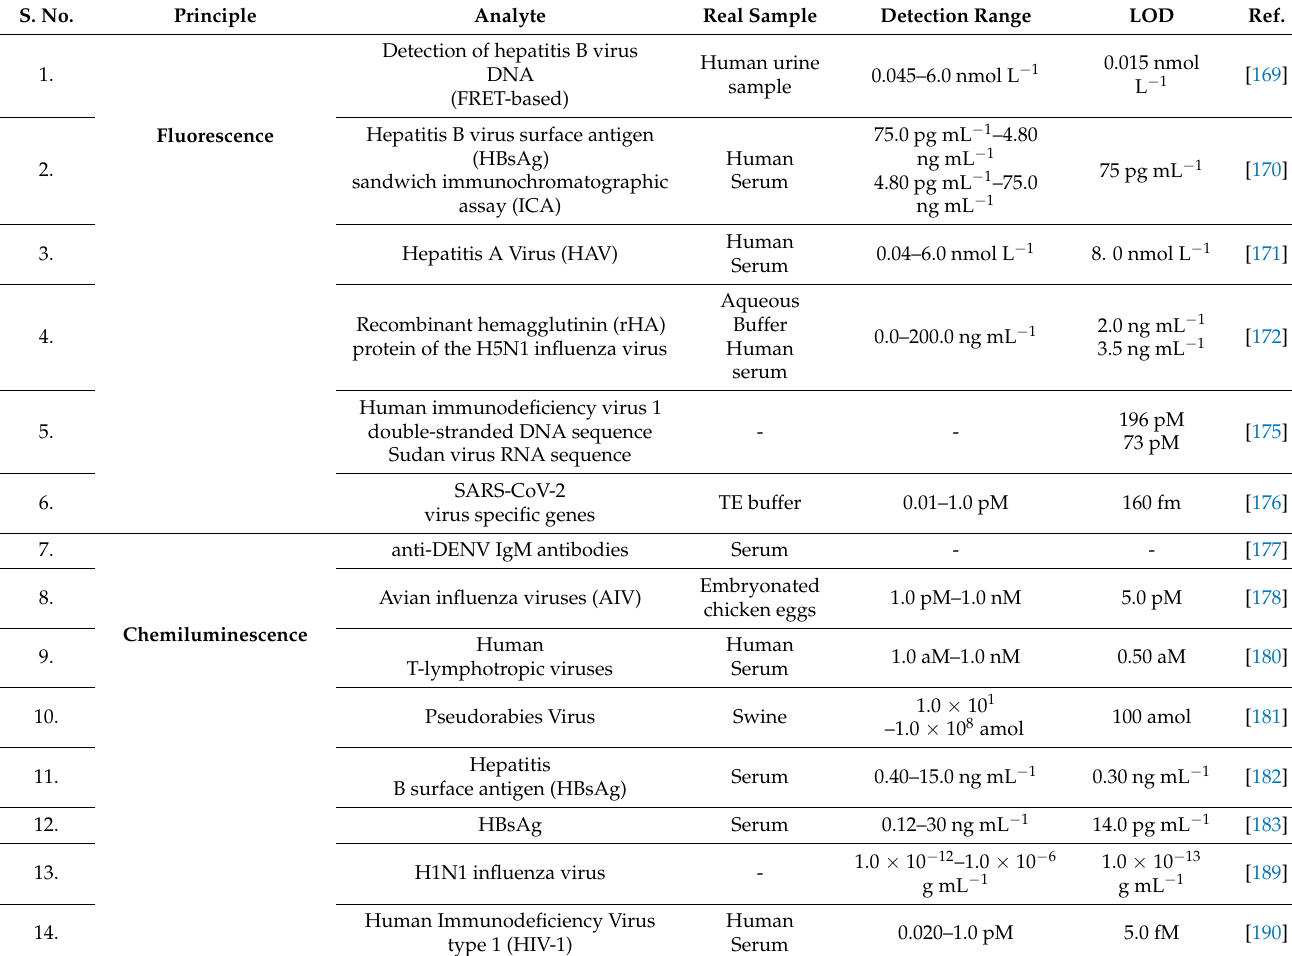
Table 2. Fluorescence/chemiluminescence-based sensing platform for viral